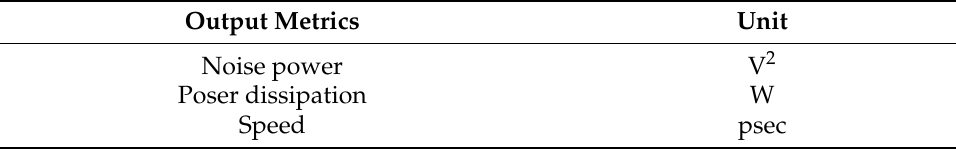
Table 5. Performance output metrics of the comparator